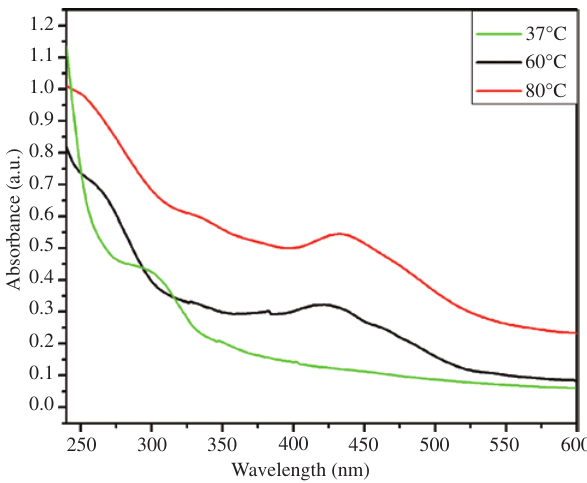
Figure 2: Effect of temperature on the synthesis of zinc sulfide nanoparticles using Chlamydomonas reinhardtii .